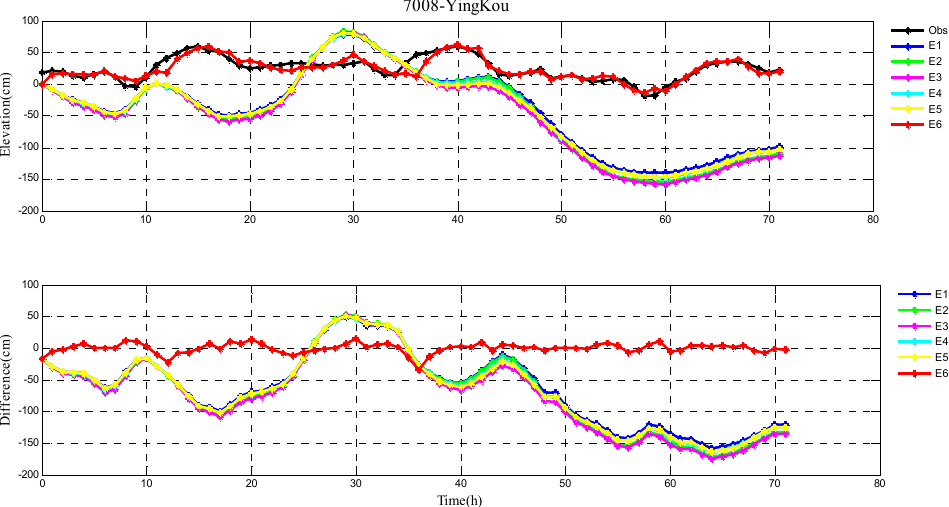
Figure 5. Storm surge elevations in six experiments (E1–E6), observations (black line) ( top ), and the differences between them ( bottom ) during Typhoon 7008 at YingKou station.